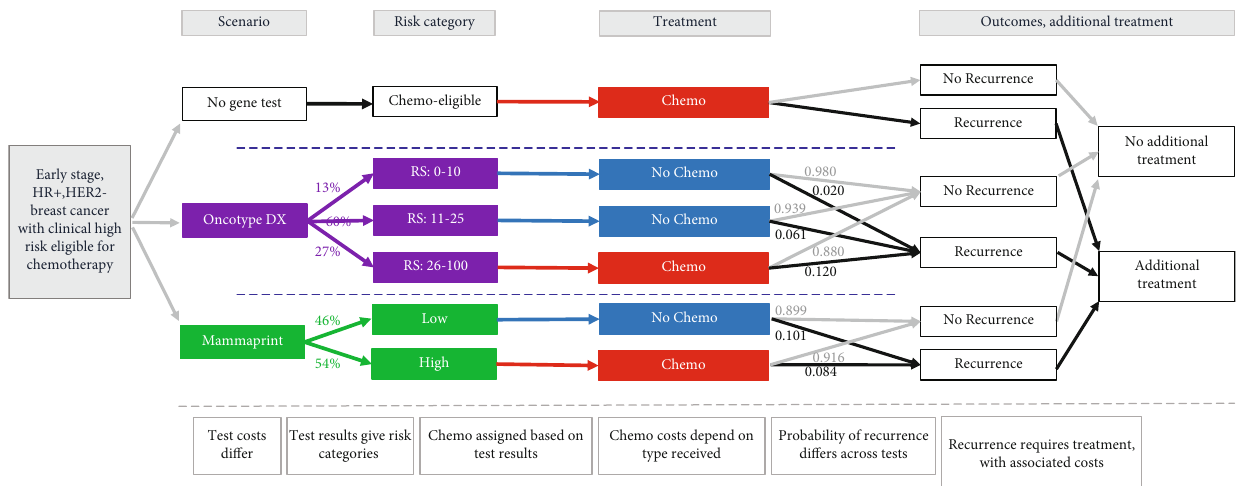
Figure 1: Diagram showing an overview of the structure for the cost-consequence